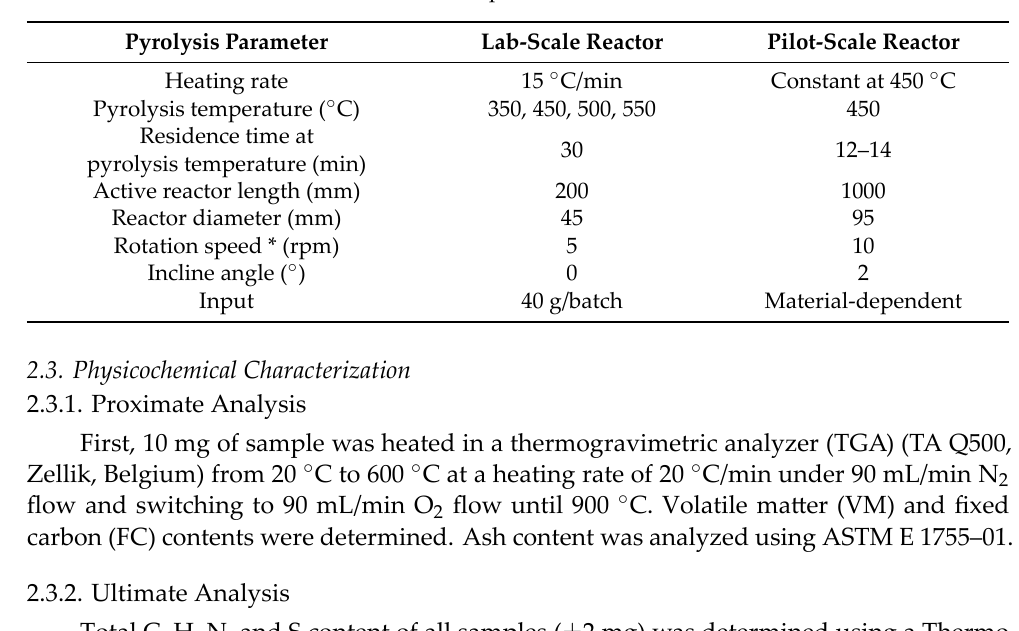
Table 1. Pyrolysis parameters of the lab‑scale and pilot‑scale reactor. * Rotation of the screw in the lab‑scale reactor and rotation of the kiln in the pilot‑scale